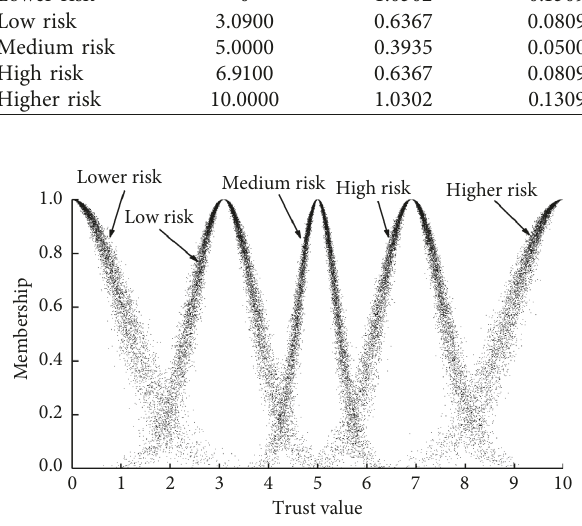
Figure 2: Cloud model of each risk level.